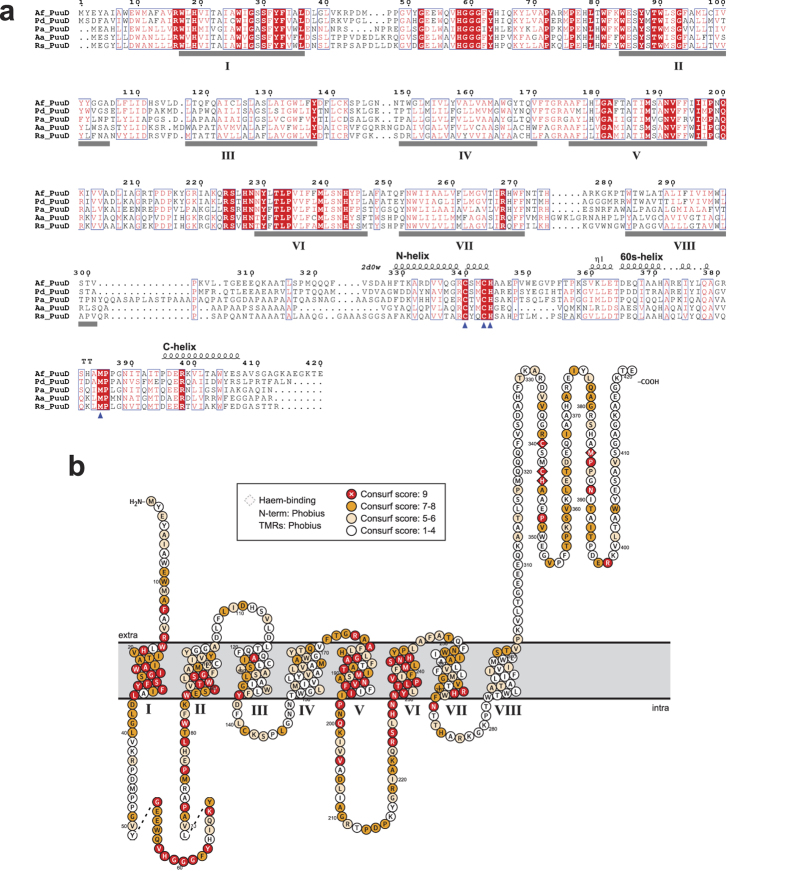
Sequence and structure organization of PuuD proteins.(a) Multiple alignment of representative PuuD sequences from Agrobacterium fabrum (Af), Paracoccus denitrificans (Pd), Pseudomonas aeruginosa (Pa), Acidovorax avenae (Aa), and Ralstonia solanacearum (Rs). Accession numbers are reported in Supplementary Table S1. Colour shading of conserved residues is based on the larger alignment shown in Supplementary Fig. S7. The identified transmembrane helices in AfPuuD are indicated by gray bars and numbered with roman numerals. Blue arrowheads indicate the residues supposedly involved in heme coordination. The secondary structure elements of the cytochrome c domain are depicted above the alignment based on the comparison with the PDB structure 2d0w; helices are named according to the mitochondrial cytochrome c notation. (b) Membrane topology of AfPuuD. Residues are colored according to the Consurf analysis60 of the PuuD multiple alignment of Supplementary Fig. S7. Topology plots were obtained with the Protter program58.